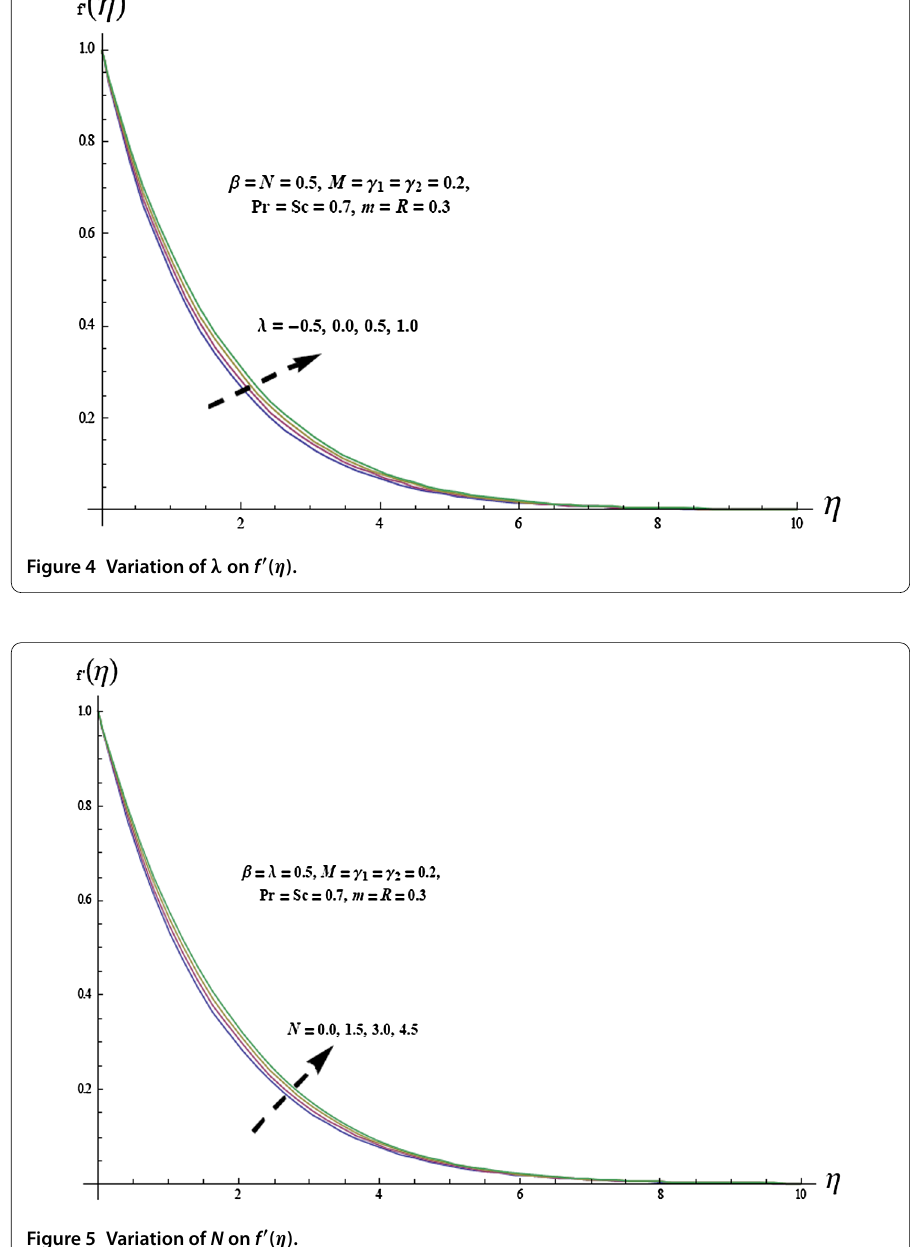
Figure 5 Variation of N on f (cid:2) ( η